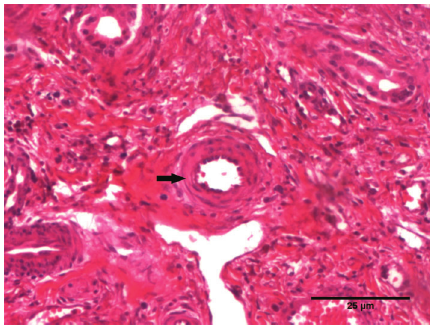
Figure 2 . Photomicrograph showing thickening of the arterial medial layer (arrow). Hematoxylin and eosin stain, (cid:1)